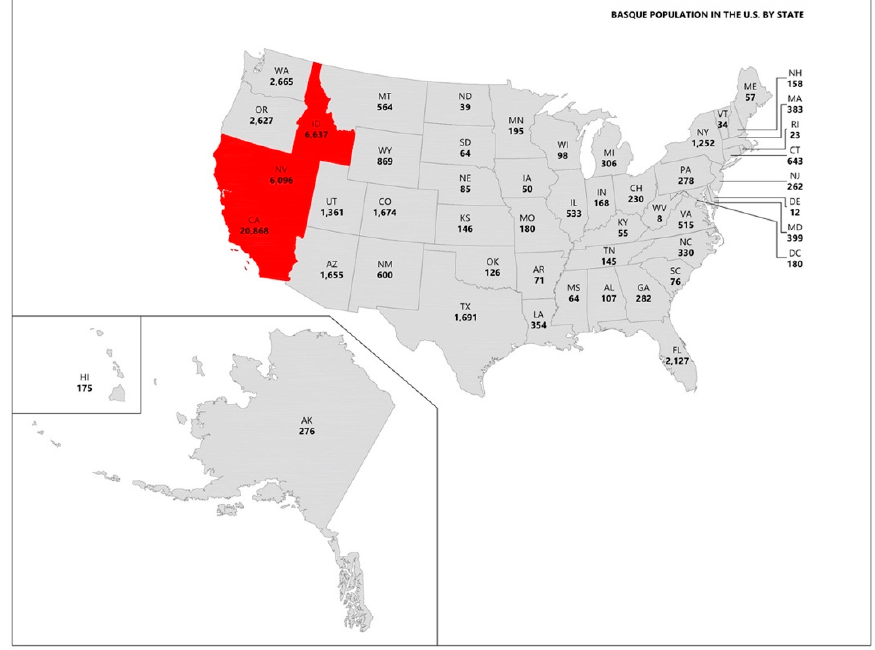
Figure 1. Basque-American Population in the U.S. by State: California (CA), Nevada (NV), and Idaho (ID). (Source: US Census 2000 via https://nabasque.eus/us_basque_population.html accessed on 1 October 2022).